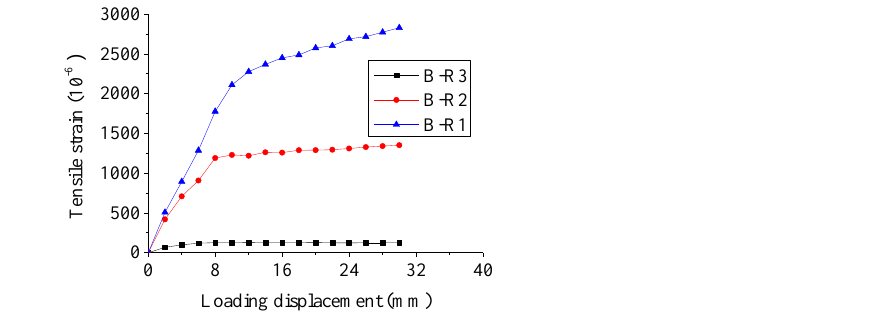
Figure 10. Relationship of loading displacement versus strain of steel dowel in Specimen JD2.